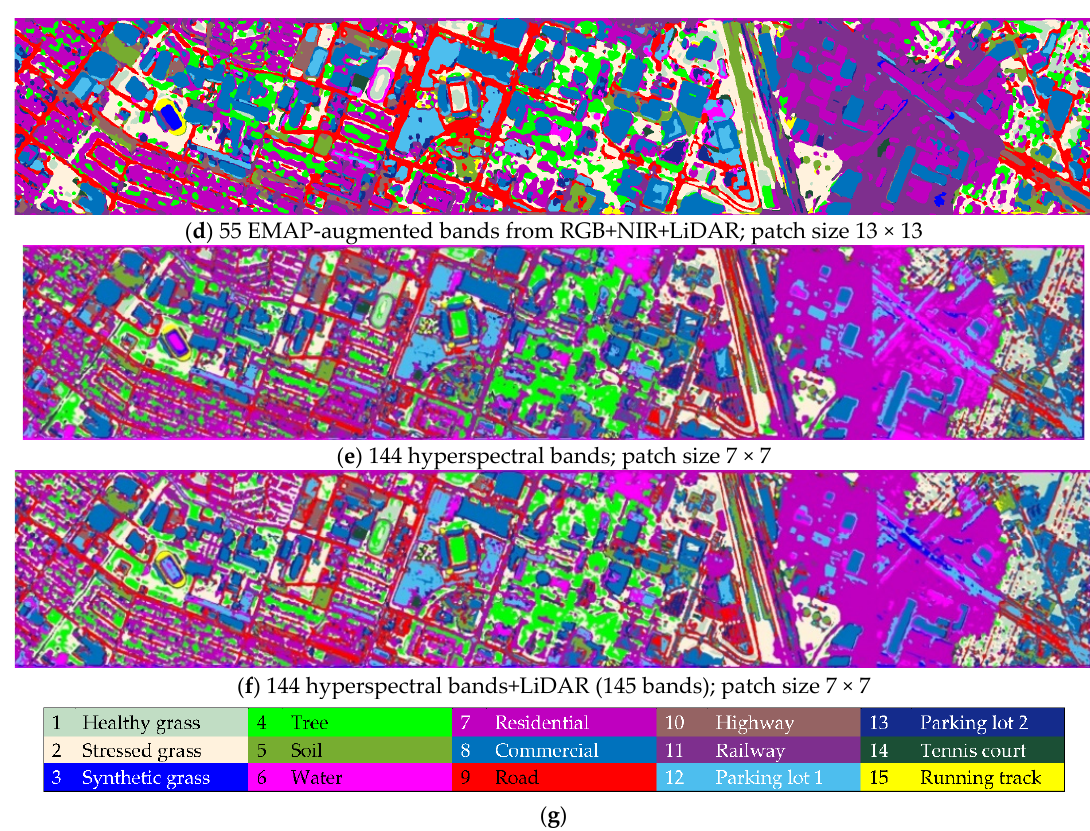
Figure 9. CNN-3D method estimated land cover maps for the whole image.